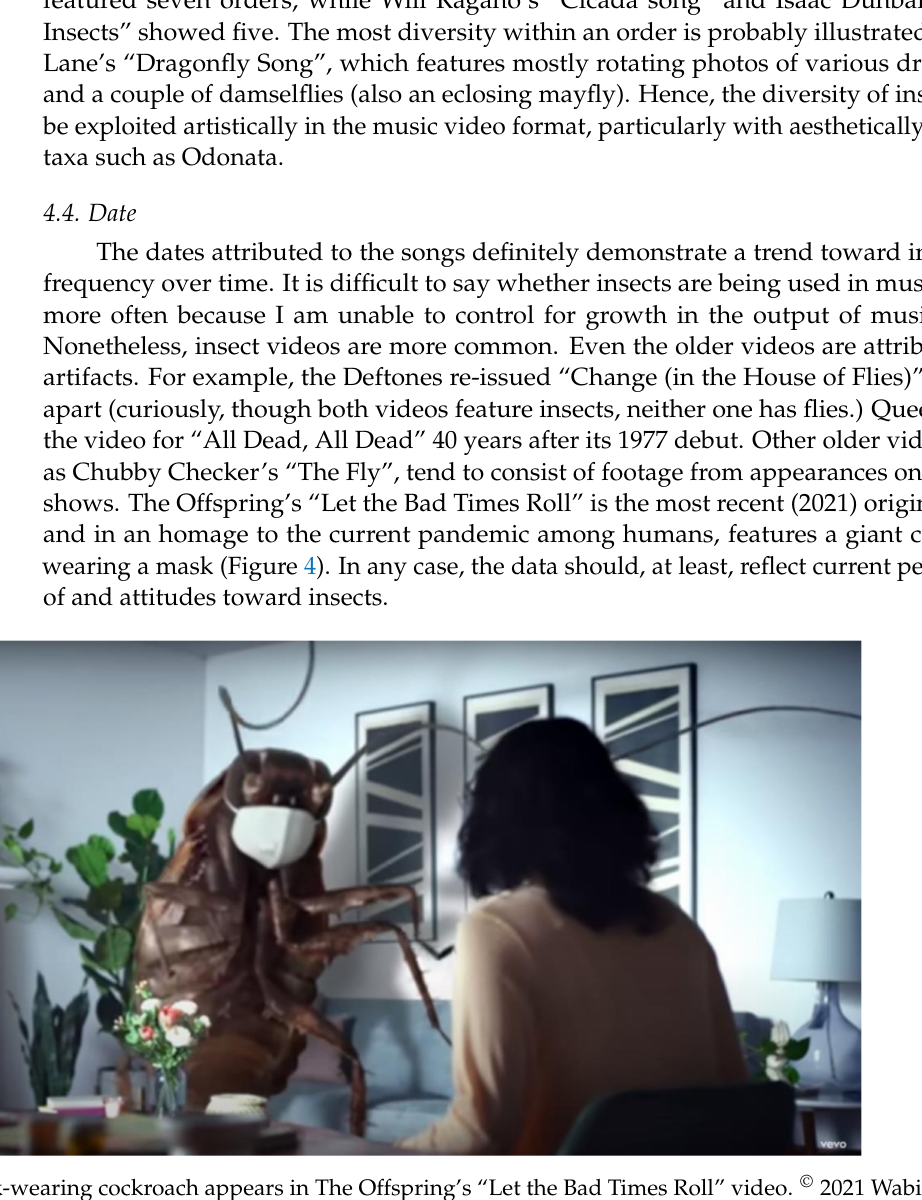
Figure 4. A giant, mask-wearing cockroach appears in The Offspring’s “Let the Bad Times Roll” video. © 2021 Wabi Sabi Worldwide,